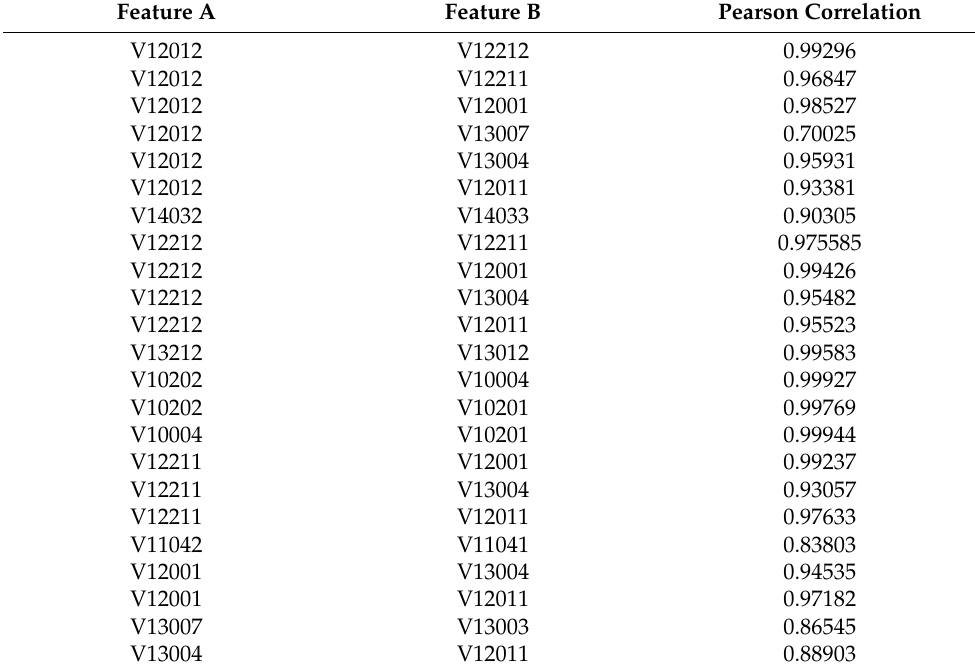
Table 4. Correlation table of climate factors.